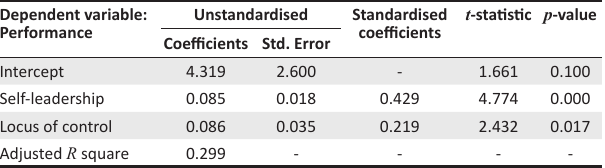
TABLE 5: Regression results (self-leadership components). Dependent variable: Unstandardised Standardised t -statistic p -value Performance coefficients Coefficients Std. Error